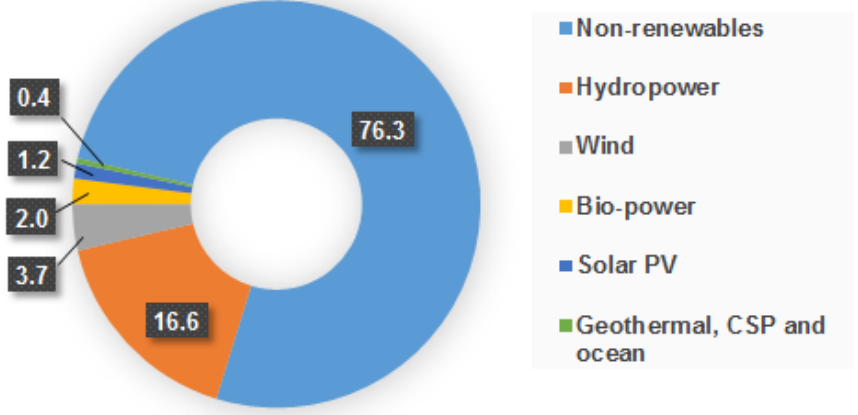
Figure 1. An estimate of RE in world power production, 2015. Adapted from